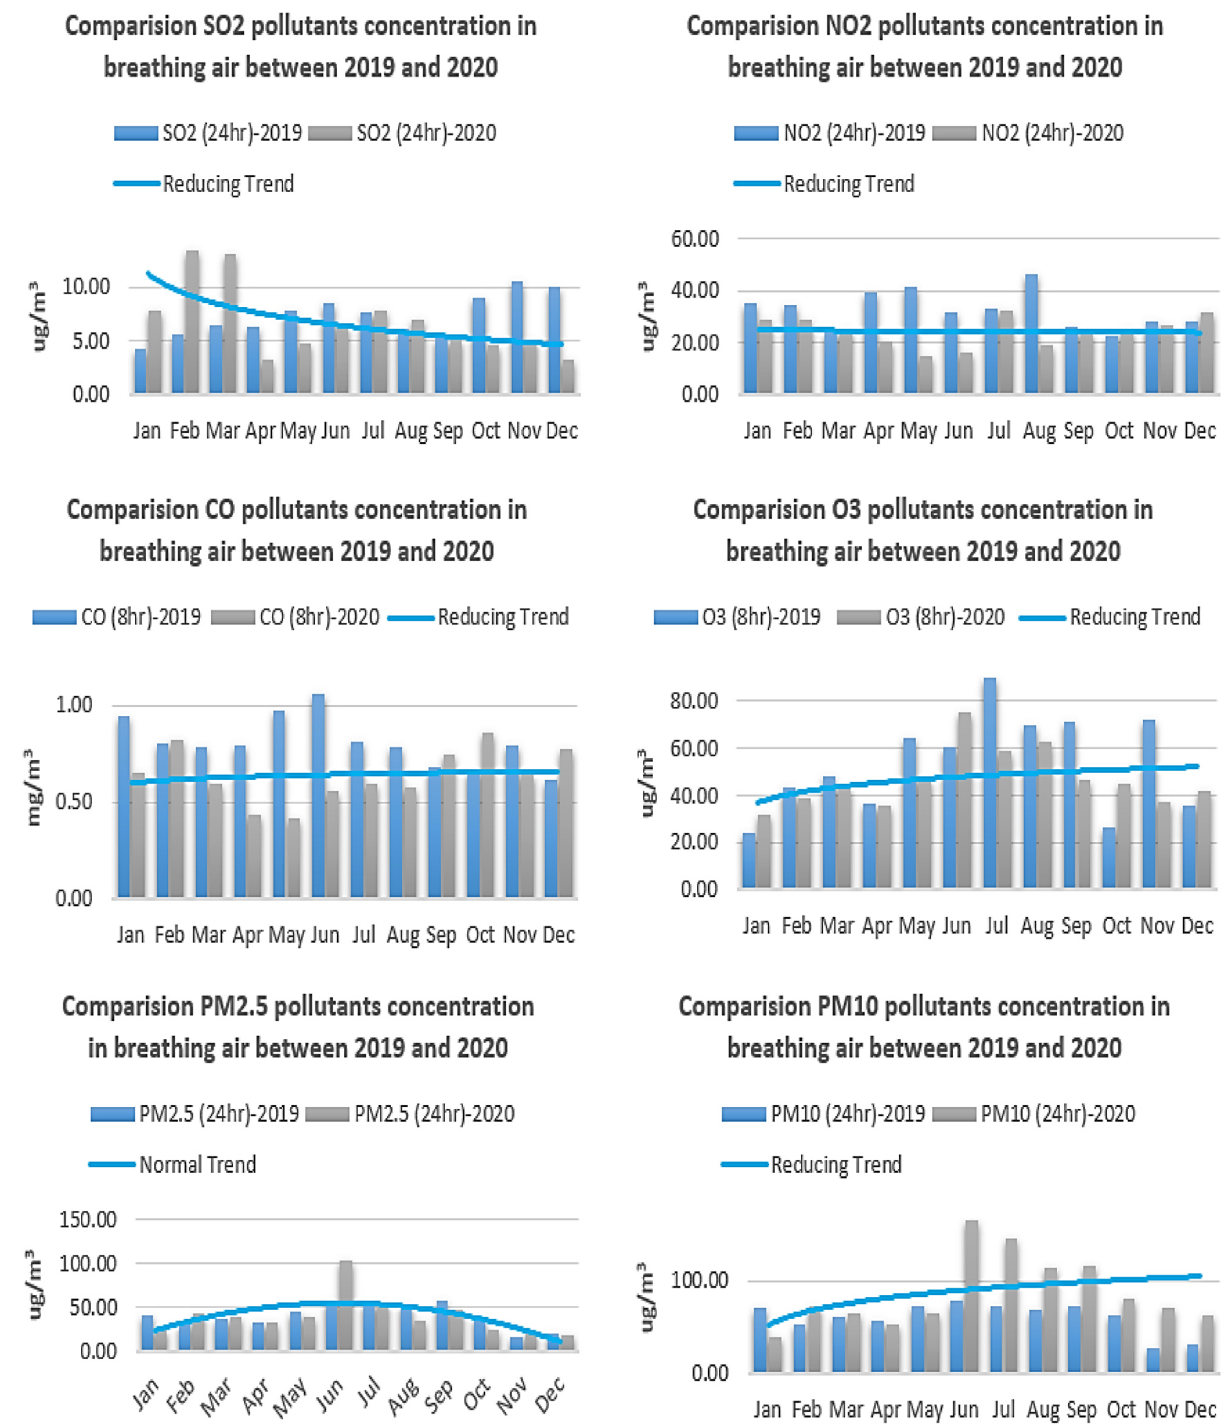
Fig. 5. Air quality data collected for the period between 2019 – 2020 [24] (see Supplementary